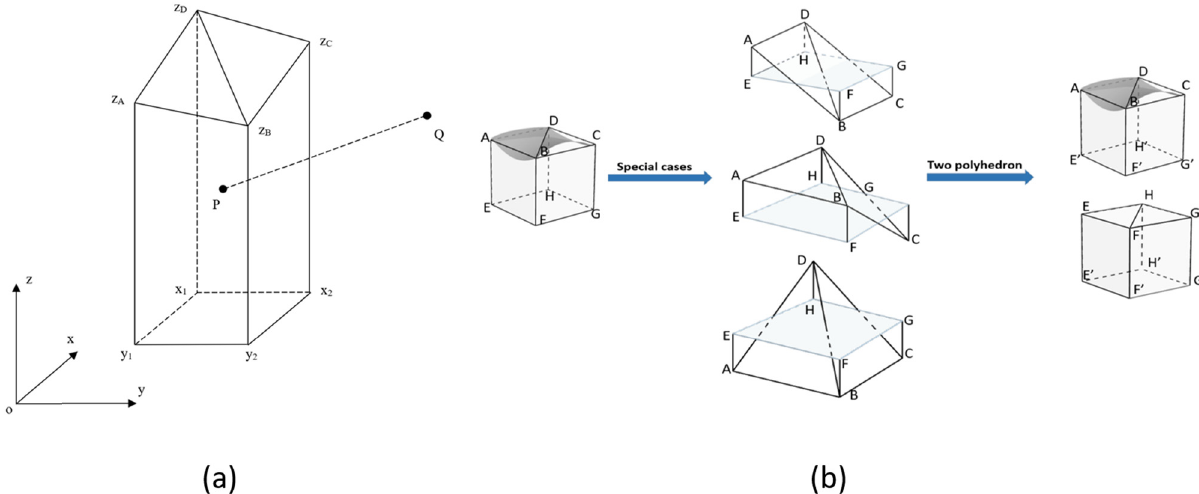
Figure 2: ( a ) Geometry of polyhedron and ( b ) special cases for polyhedron. Source: ( b ) Yang et al. ( 2020 )